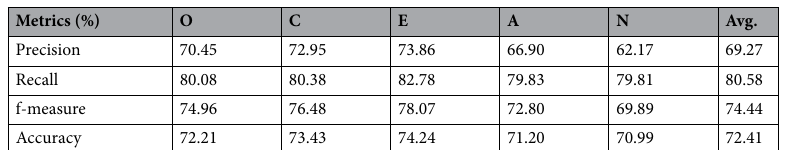
Table 4. Evaluation results for APP using KGrAt-Net when classification is performed using knowledge graph attention network along with knowledge graph embedding.